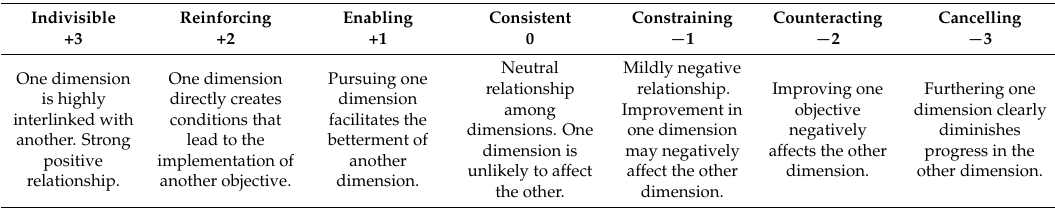
Table 3. Rating interlinkage effects among dimensions 1